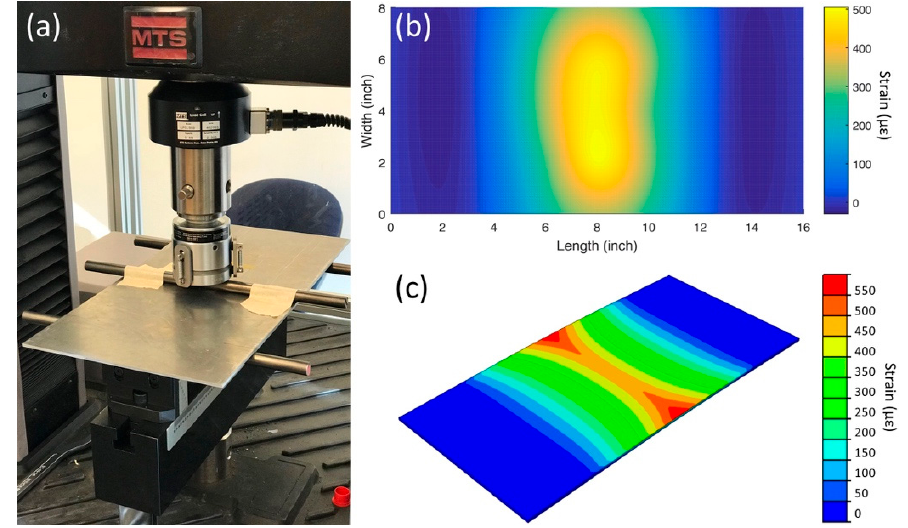
Figure 10. ( a ) Experimental setup of the 3-point bending test; ( b ) Contour plot of the measured strains upon load increments to the coupon; ( c ) Simulated strain profile with a 50 lbf bending force.